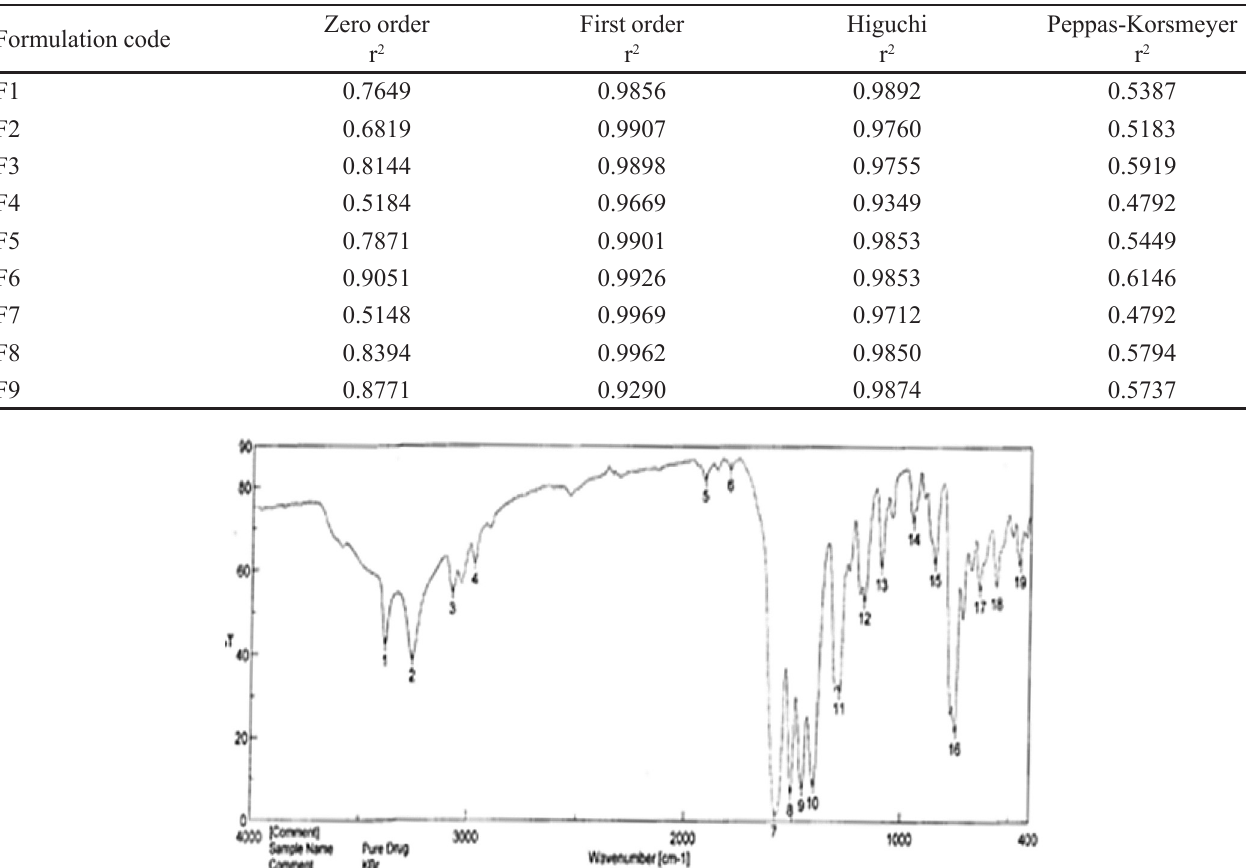
FIGURE 7 (a) - FTIR Spectroscopic analysis of pure sodium